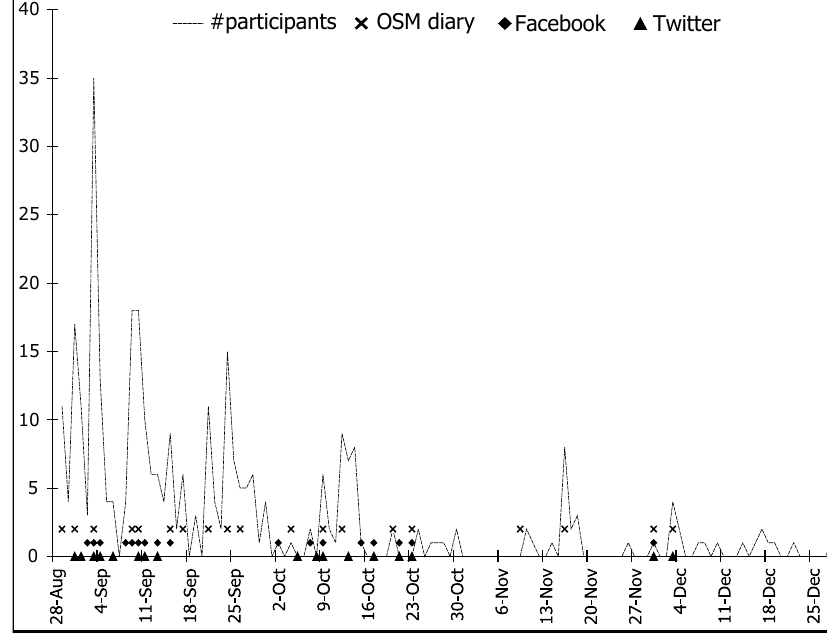
Figure 10. Numbers of participants per day relative to the announcement